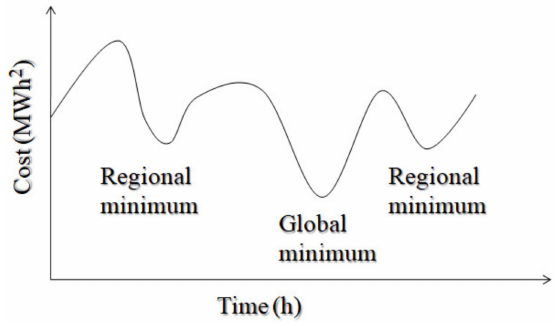
Figure 2. The cost of the fuzzy logic